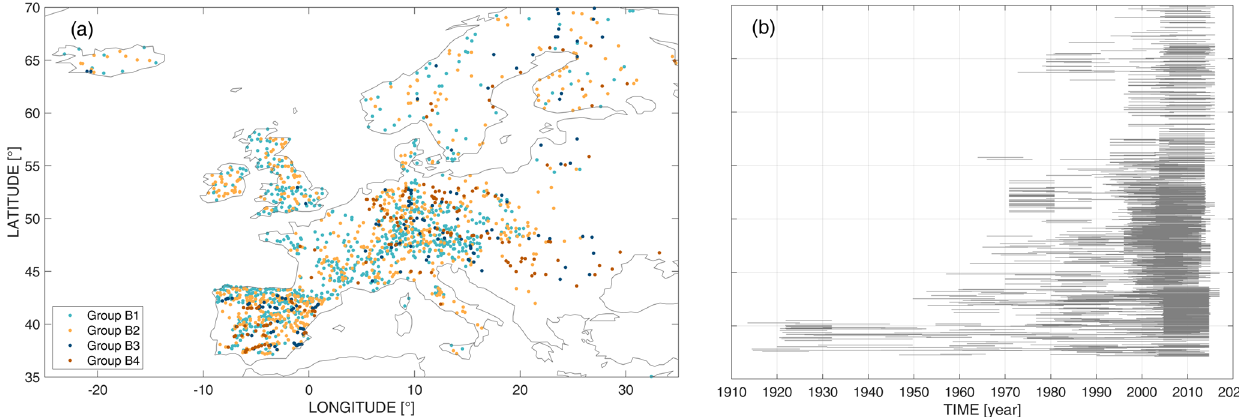
Figure 1. (a) Location of the selected gauge stations where the river discharge is recorded (based on the Global Runoff Data Centre and the Italian and Spanish basin authority datasets) and (b) operating period for each ground station from 1913 to 2016 listed based on the